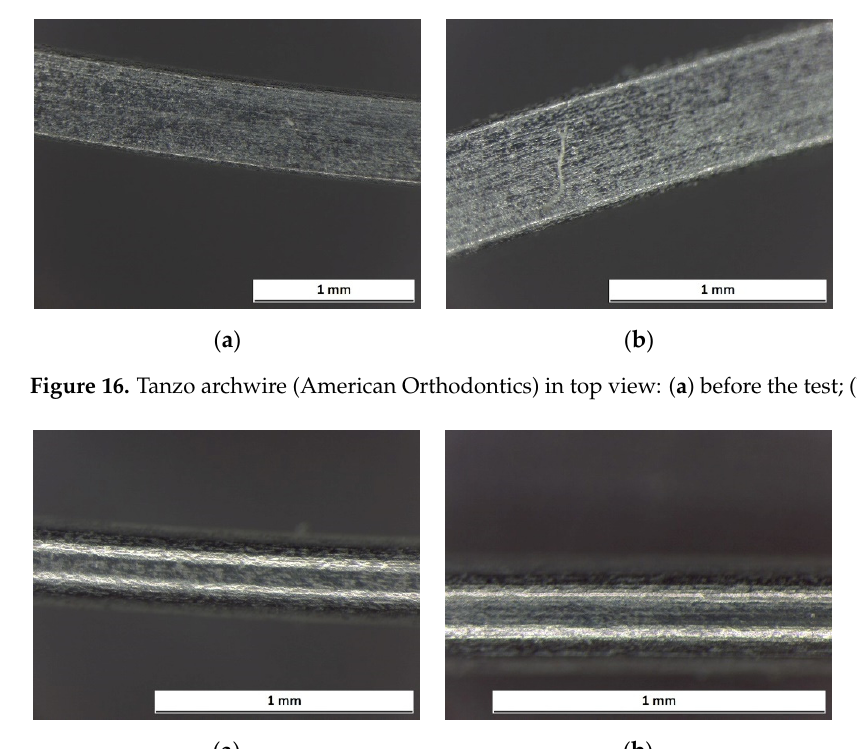
Figure 15. Spektra TH Plus archwire (Micerium Orthodontics) in top view: ( a ) before the test; ( b ) after the test.